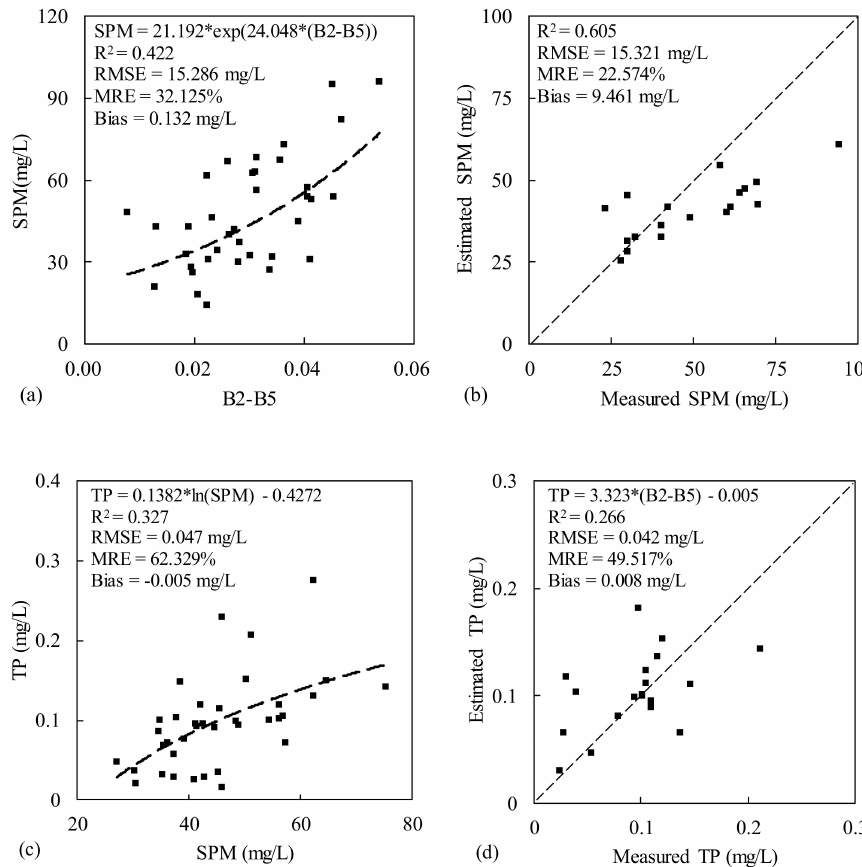
Figure 3. The optimal algorithms obtained by the indirect derivation method: ( a ) The relationship between the in situ measured SPM and (B2 − B5); ( b ) the validation of the MODIS-estimated SPM with the in situ measured SPM based on an independent dataset; ( c ) the relationship between the in situ measured TP and MODIS-estimated SPM; ( d ) the validation of the indirect derivation method-estimated TP with the in situ measured TP based on an independent